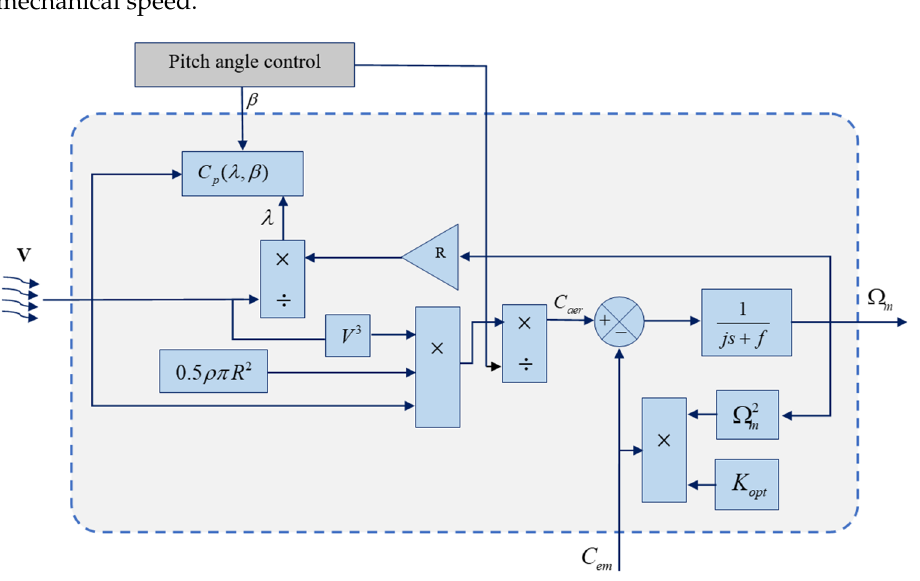
(6) Figure 3. Cp versus λ . To recuperate the maximum amount of the available kinetic wind power, the blade pitch angle is zero, which corresponds to optimal C p and λ values for the operation in an MPPT mode. However, it is important to limit the turbine’s rotational speed in case the wind speed exceeds the nominal speed to protect the system from mechanical problems. In this work, the control system, called “pitch control”, should be added to jointly control the speed as well as the power of the wind turbine and necessarily limit them once the rated value of the wind speed is exceeded. Figure 4 describes the pitch control system operation.